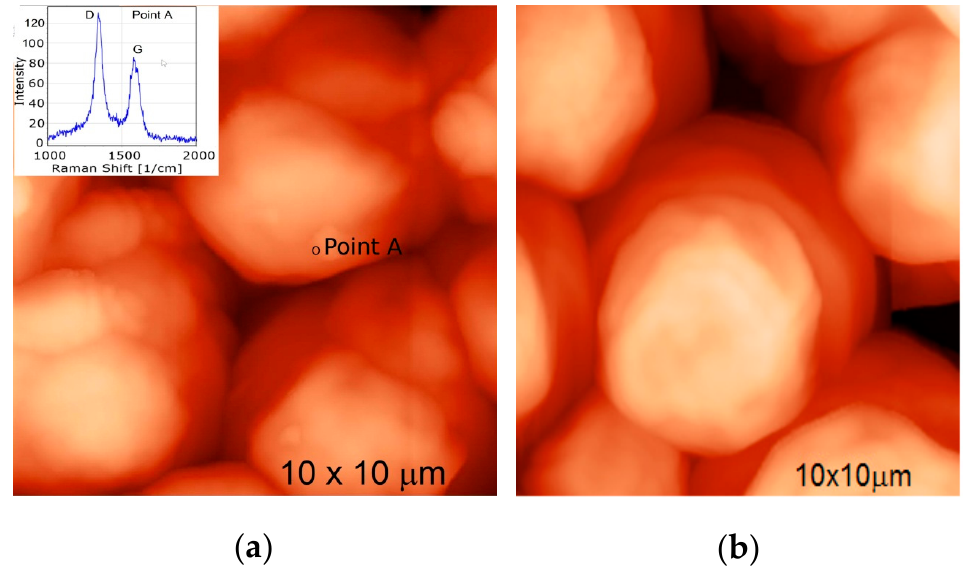
Figure 8. AFM image of yeast cells: ( a ) AFM image of yeast cells and Raman spectra of MW-CNTs at